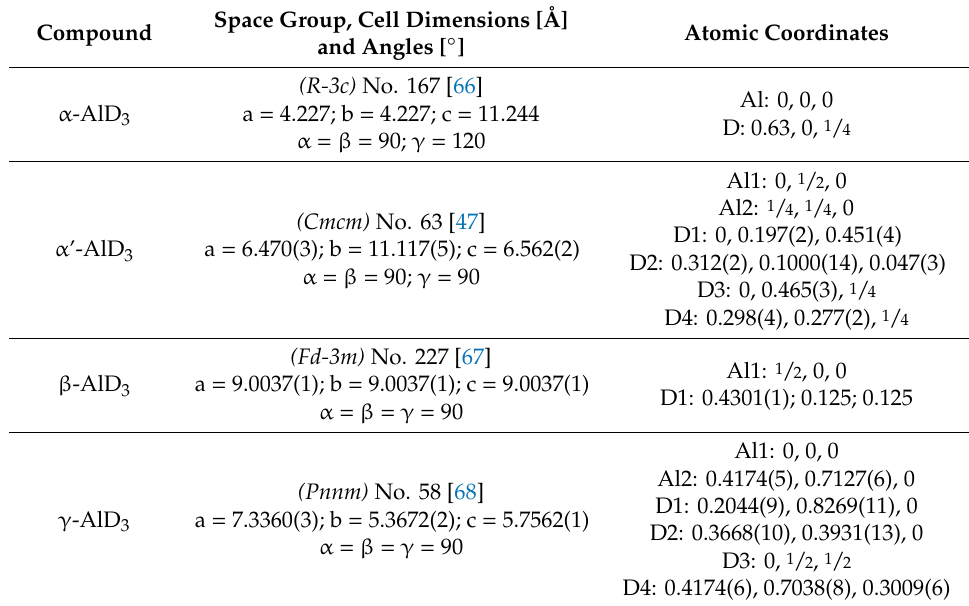
Table 1. Crystallographic data of alanes.